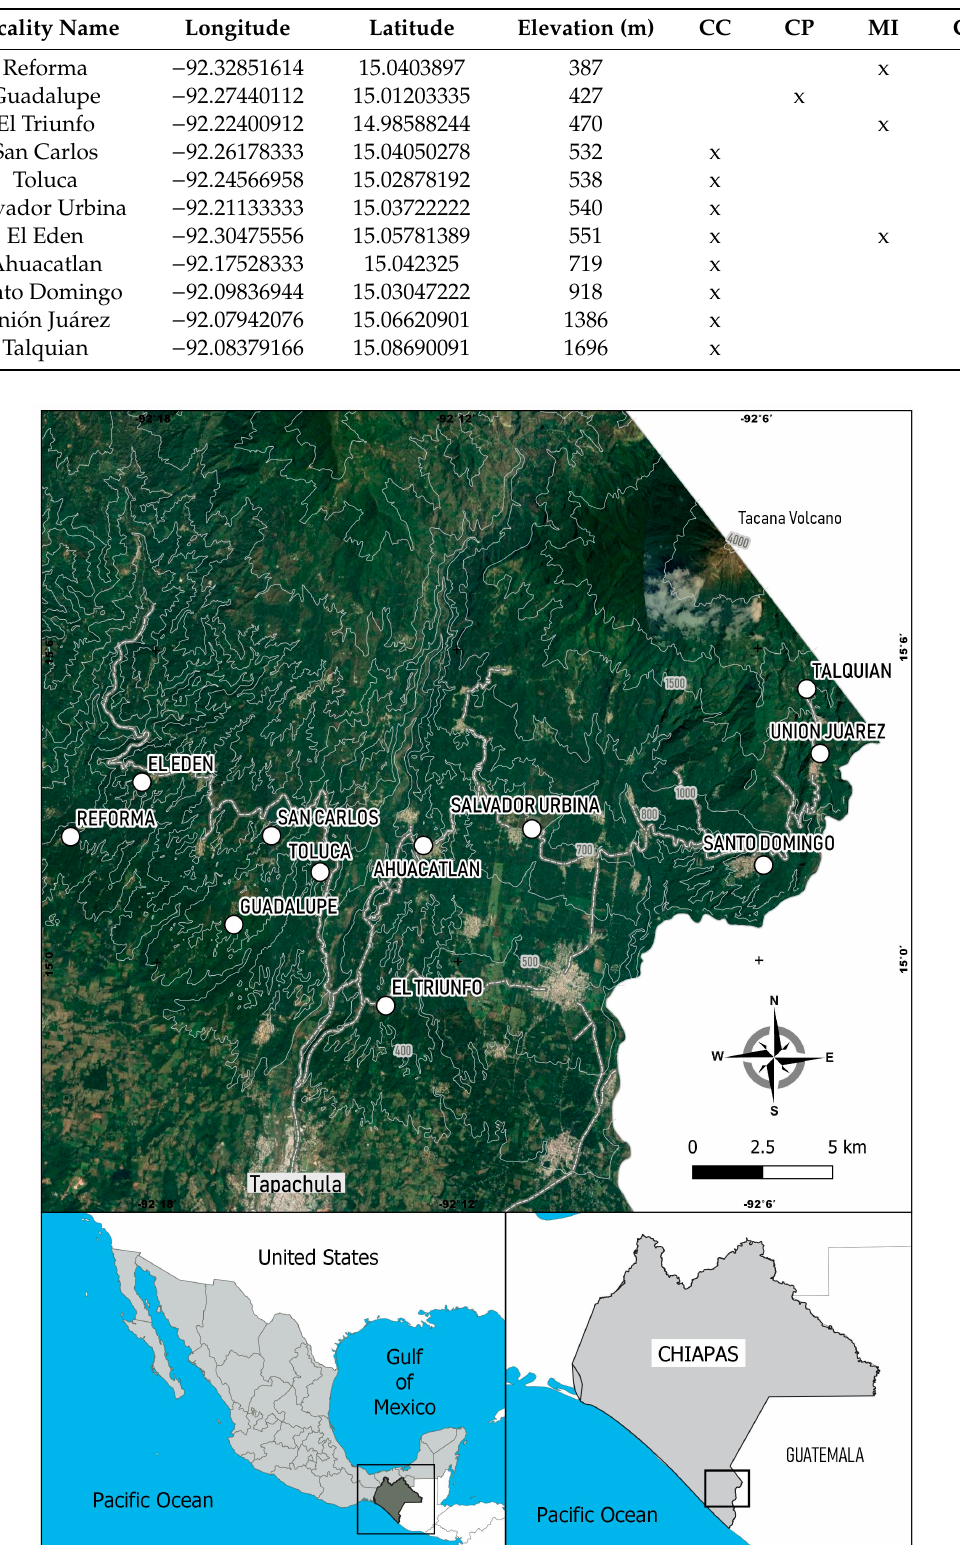
Table 1. Collection localities and hosts of Anastrepha ludens in the Soconusco region of Chiapas, Mexico. CC, Citrus sinensis ; CP, Citrus paradisi ; MI, Mangifera indica ; CE, Casimiroa edulis .